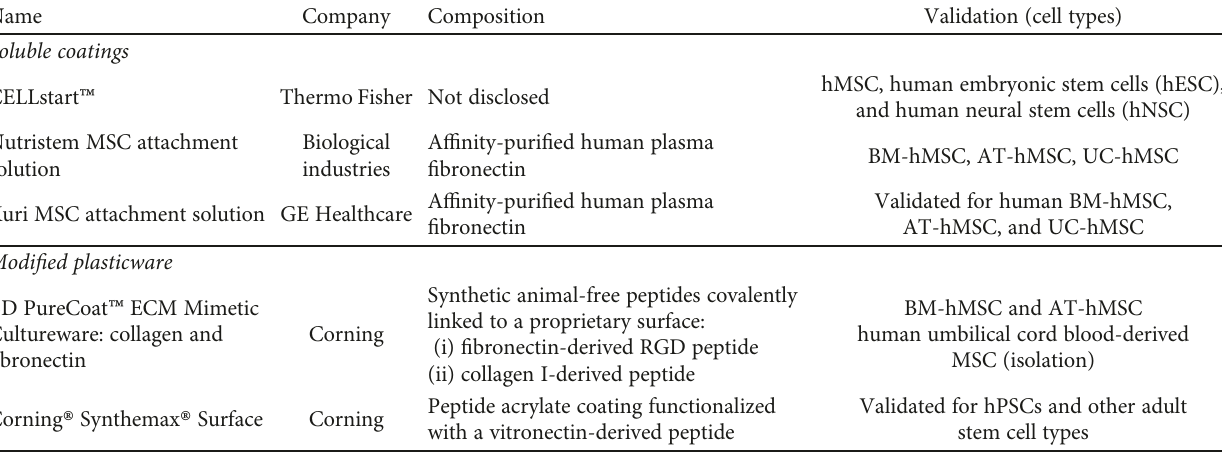
Table 4: Commercially available coating strategies for hMSC in vitro